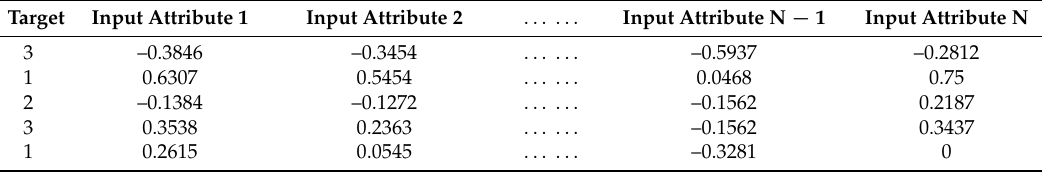
Table 1. Training labels embedded in the first column of the training